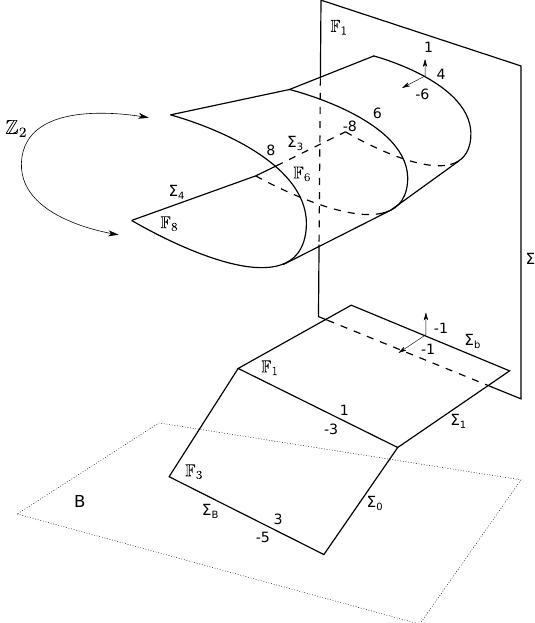
Figure 1 . Compact curves and compact divisors in the n = 5 local elliptic Calabi-Yau from